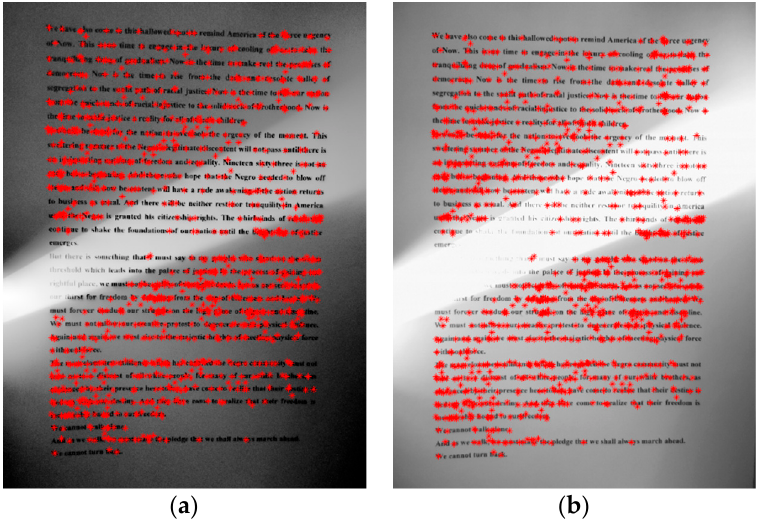
Figure 6. ( a ) Selected SIFT feature points for a well-exposed image (Figure 1a); ( b ) Selected SIFT feature points for an over-exposed image (Figure 1c).